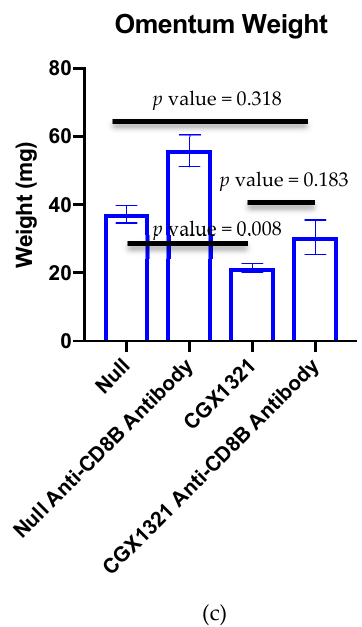
Figure 7. CD8 + T cells were required for Wnt inhibition to significantly inhibit tumor progression in ID8 in vivo model. ( a ) Graphical depiction of increased Wnt ligand leading to decreased CD8 + T cells effector differentiation in the TME. ( b ) Timeline of C57Bl/6 ID8 tumor challenge, with anti-CD8 + β antibody injection, with or without CGX1321 treatment. ( c ) Tumor progression increased with CGX1321 treatment in the absence of CD8 + T cells in ID8 omentum.